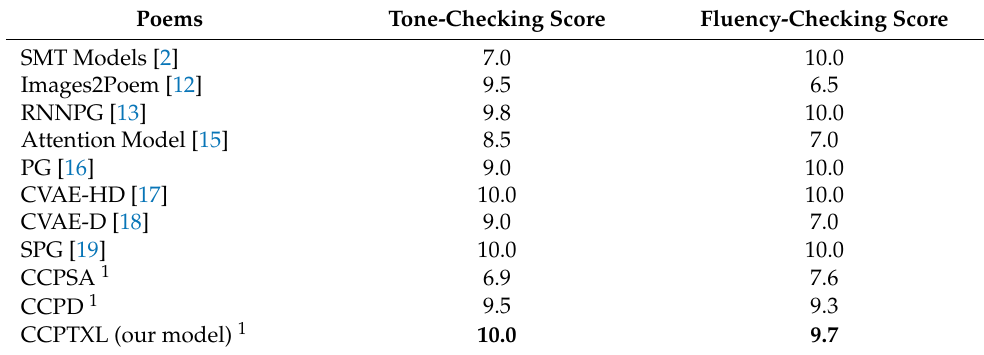
Table 2. The Comparison of Poems’ Scores. Poems Tone-Checking